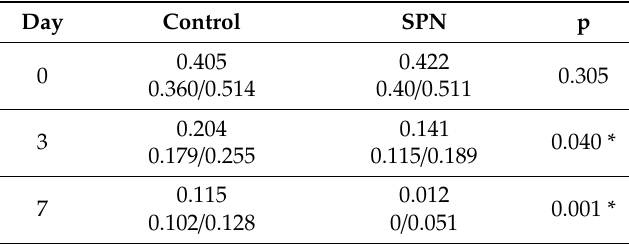
Table 3. Changes in the volume of wounds in both groups